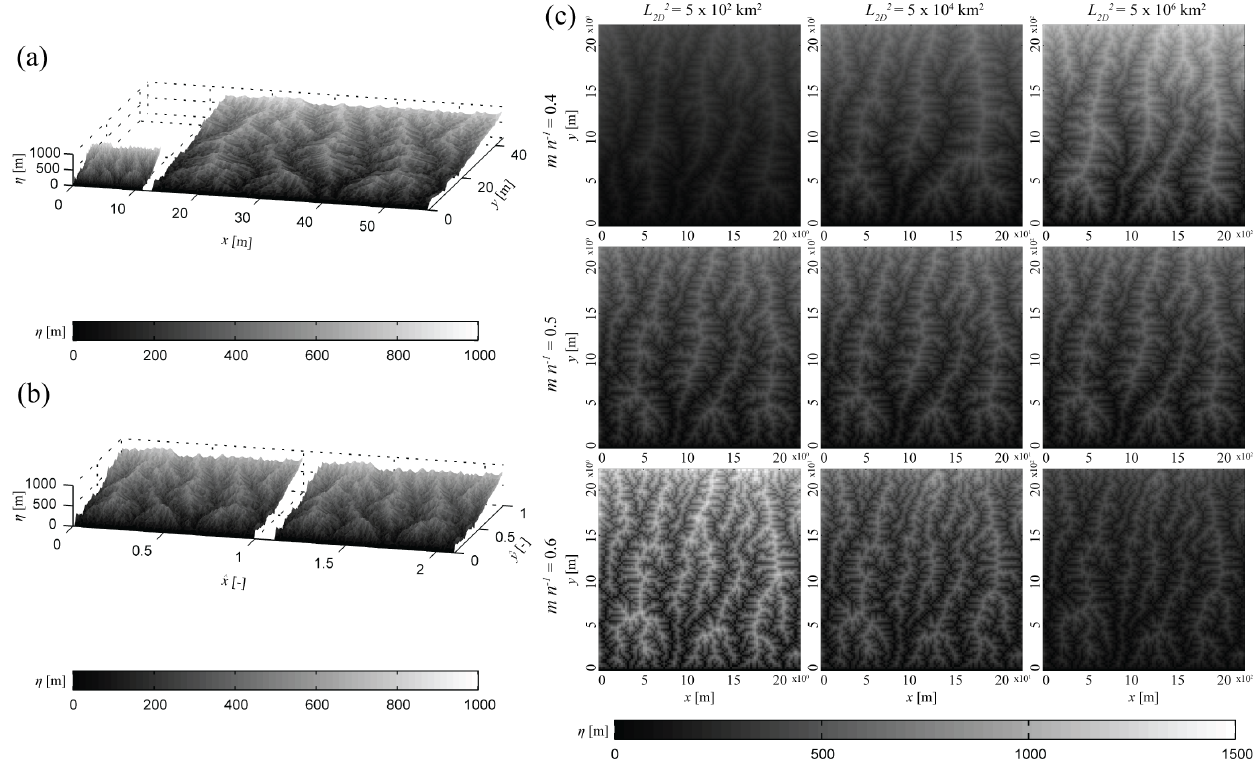
Figure 2. (a) Two-dimensional numerical landscapes at steady state using a ratio of m/n = 0.5, n = 1.0, υ = 4mmyr − 1 , = 125 and 2000km 2 . For each case, the 2-D Pillsbury number was the same: 2.73 × 10 21 . K = 2.83 × 10 − 11 s − 1 , M 2 = 100 2 cells, and L 2 2-D (b) Results of panel (a) expressed in terms of dimensionless horizontal scale. Each basin is made dimensionless by its basin size, L 2-D . (c) Nine 2-D numerical simulations at dynamic equilibrium for three different values of L 2-D and three different values of m/n . The = 5 × 10 2 , 5 × 10 4 , value of K has been chosen to be different for each value of m/n for clarity in the figures. From left to right, L 2 2-D and 5 × 10 6 km 2 . To make the relief of the landscapes comparable, the 2-D Pillsbury number, P 2-D , is set to 2.73 × 10 21 for solu- = 5 × 10 2 km 2 . To achieve this for υ = 4mmyr − 1 , K = 2.10 × 10 − 10 m 0 . 2 s − 1 , 2.83 × 10 − 11 s − 1 , and tions of all m/n ratios with L 2 2-D 3.82 × 10 − 12 m − 0 . 2 s − 1 for m/n = 0.4, 0.5, and 0.6,